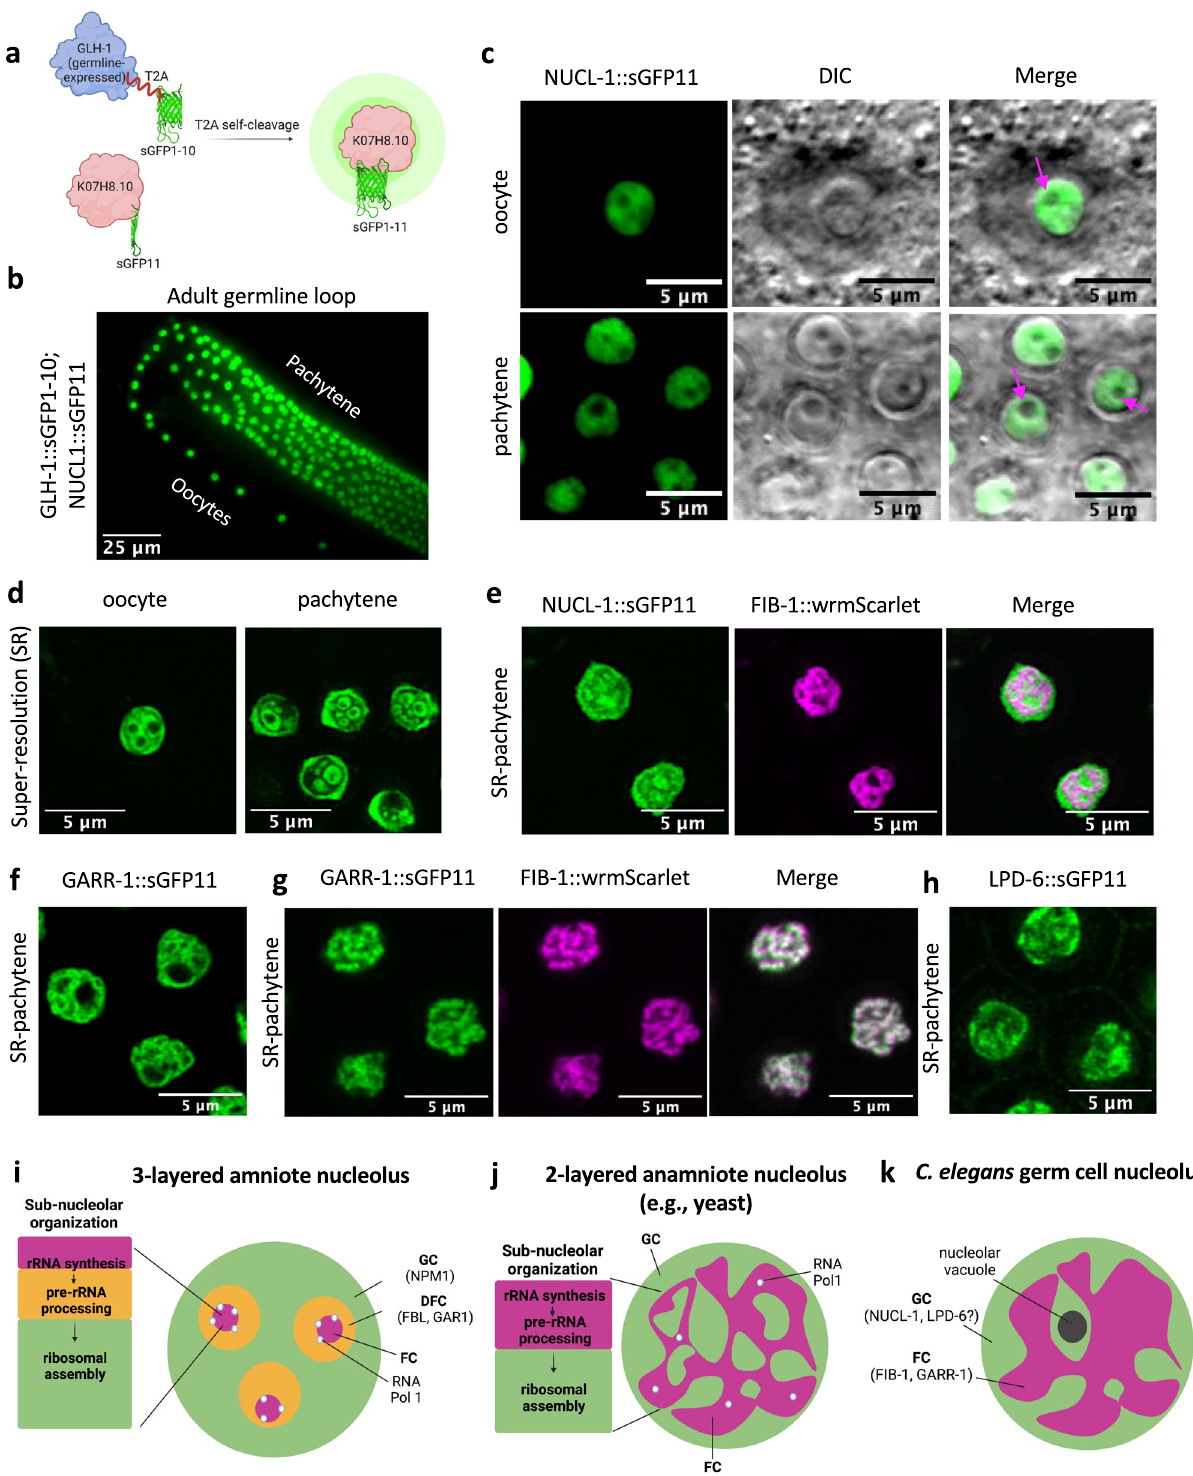
Fig.2|NUCL-1localizestogermcellnucleolianddisplaysprecisesub-nucleolar compartmentalization. a Split-GFP strategy for K07H8.10 (NUCL-1) visualization inthegermline. b NUCL-1localizestonucleoliintheadultgermline. c Confocal-DIC imaging reveals that NUCL-1 localizes exclusively to the nucleolus in oocytes and pachytene germ cells. Pink arrows indicate nucleolar vacuoles. d NUCL-1 displays precise sub-nucleolar organization within oocytes (1 nucleolus shown) and pachytenegermcells(5nucleolishown). e NUCL-1andFIB-1occupydistinctspaces in pachytene germ cell nucleoli. f GARR-1::sGFP11 in pachytene germ cell nucleoli.